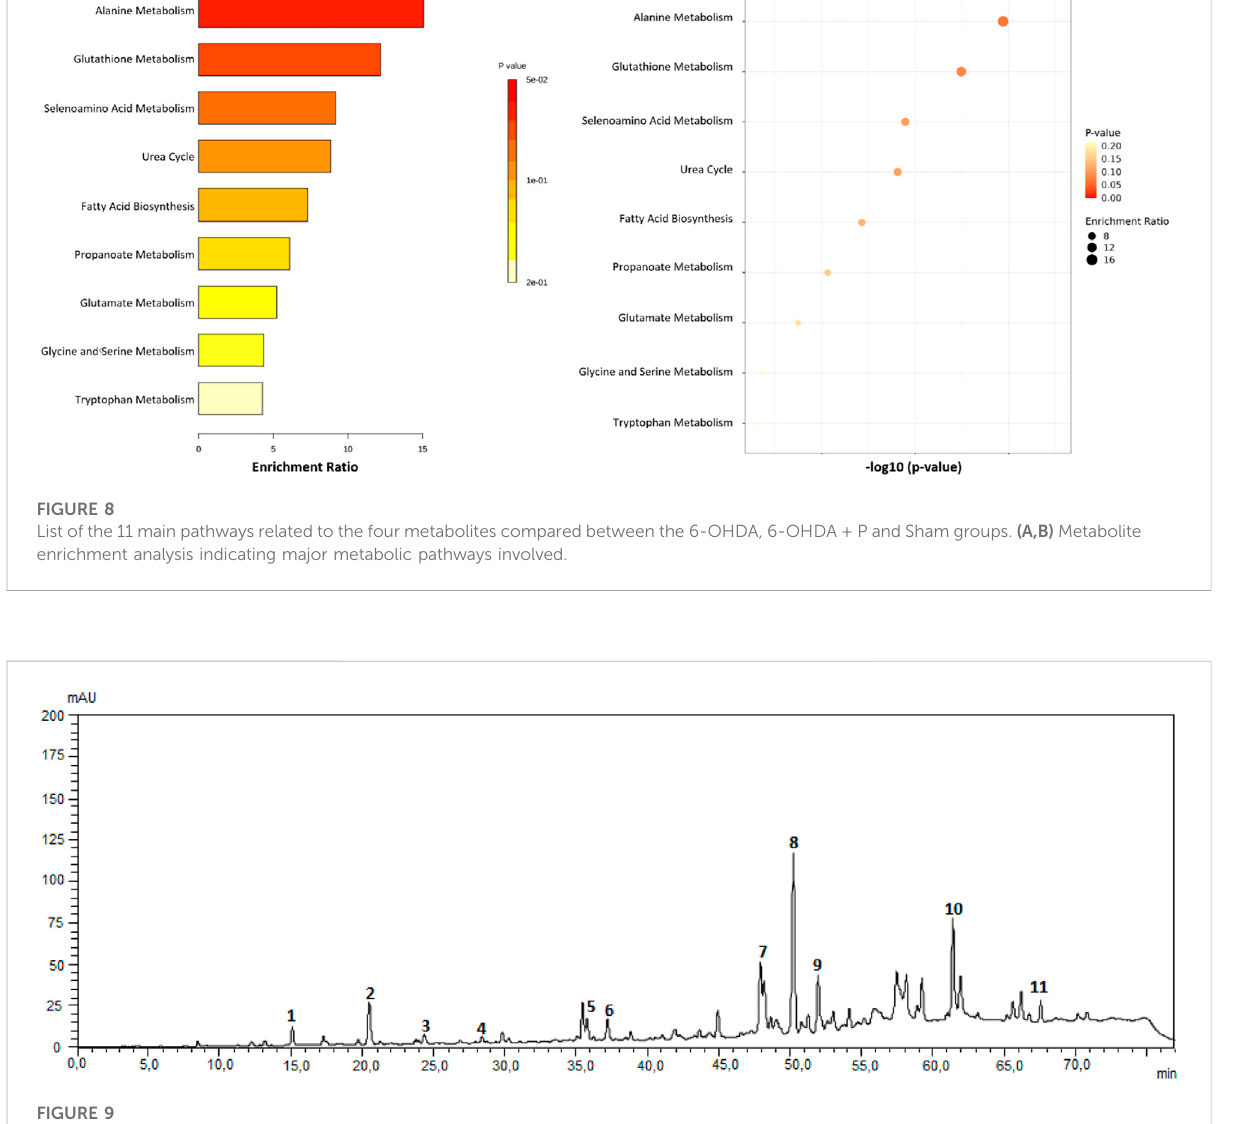
FIGURE 9 Chromatographic fi ngerprint of Propolis EPP-AF(R)-C obtained using a Shimadzu HPLC system, with LC-20AT quaternary delivery system, equipped with an autosampler, a CTO-10AC column oven, and a DAD-SPD-M20 A photodiode array detector, reverse-phase Shim Pack CLC-ODS (C18) was used analytical column (250 mm × 4.6 i.d, and a particle size of 5 um) from Shimazu and a pre-column was also used. The mobile phase consisted of a linear gradient of MiliQ acidi fi ed water with 0.1% of formic acid (pH 2.7) (A) and metanol (B) , from 20% to 80% of B, in 70 min (Berretta etal.,2012).Thewavelengthused was275 nm andthe fl owrate was0.8 ml/min.Authenticatedstandardwereusedfor theidenti fi cationof the peaks, that were quanti fi ed with an analytical curve for each. (1) caffeic acid, (2) p-coumaric acid, (3) 3,5-dicaffeoylquinic acid, (4) 4,5- dicaffeoylquinic acid, (5) cinnamic acid, (6) aromadendrin-4 ′ -O-methyl ether, (7) drupanin, (8) crysin, (9) galangin, (10) artepellin C, and (11)